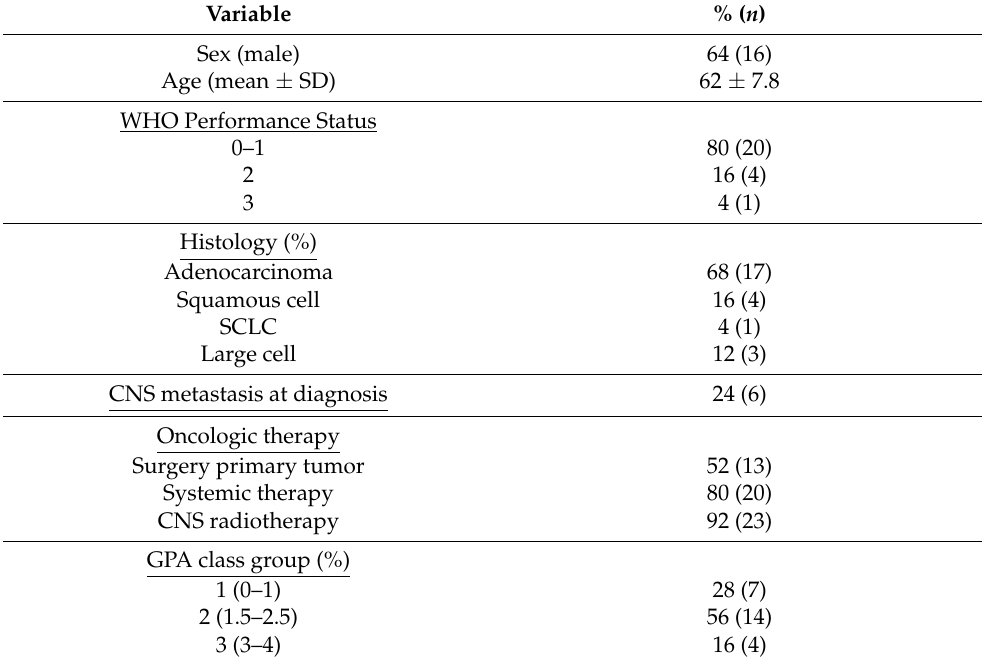
Table 1. Baseline demographics and disease